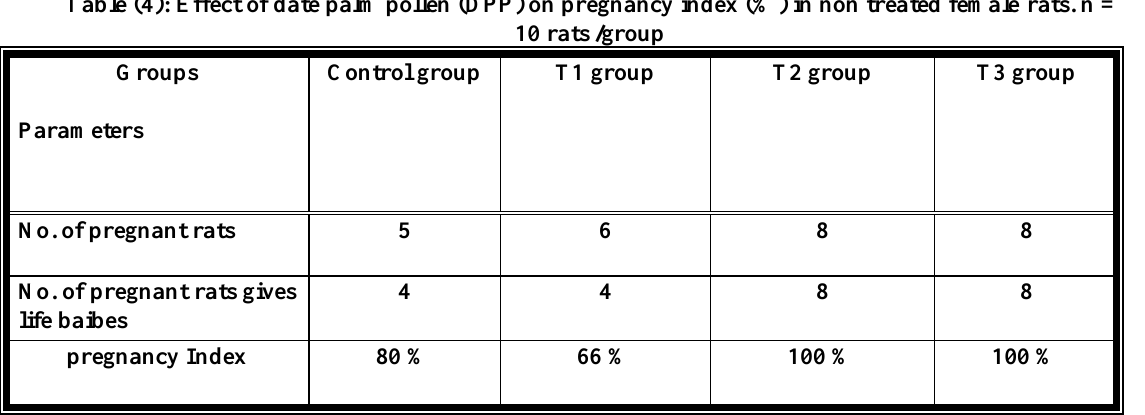
Table (4): Effect of date palm pollen (DPP) on pregnancy index (%) in non treated female rats. n